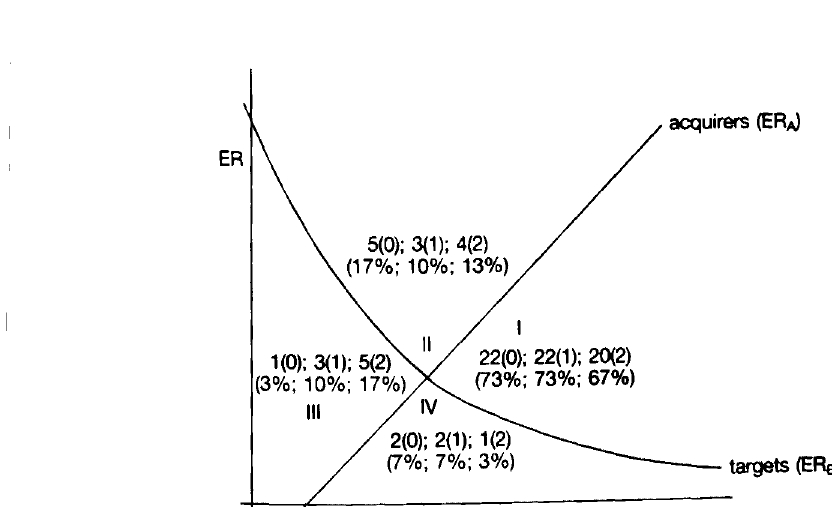
Figure 2 The distribution of 30 mergers into the four quadrants of the